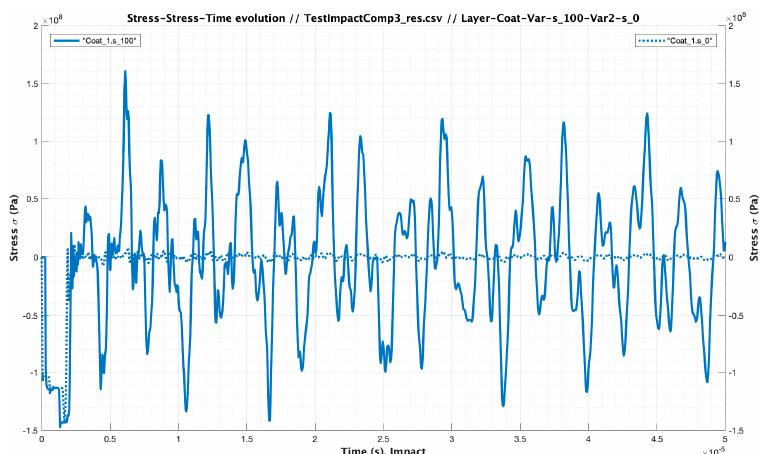
Figure 20. Stress-Time evolution for Case 1 at surface (s = 0) and interface (s = 100).